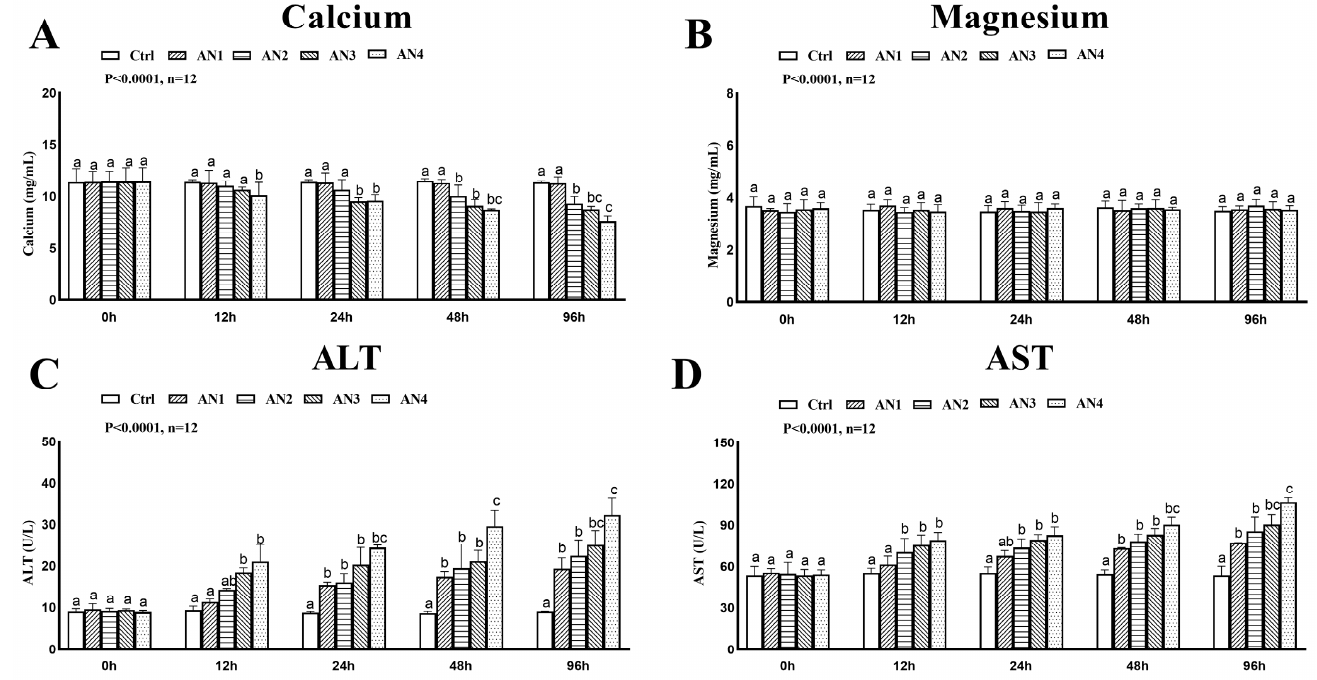
Figure 3. Changes of plasma biochemistry of bighead carp exposed to ammonia. ( A ) Calcium, ( B ) magnesium, ( C ) alanine aminotransferase (ALT), and ( D ) aspartate aminotransferase (AST). Values are expressed as mean ± standard error (SE) from triplicate groups ( n = 12). Bars with different letters (a, b, c differ significantly from those of other groups ( p < 0.05).